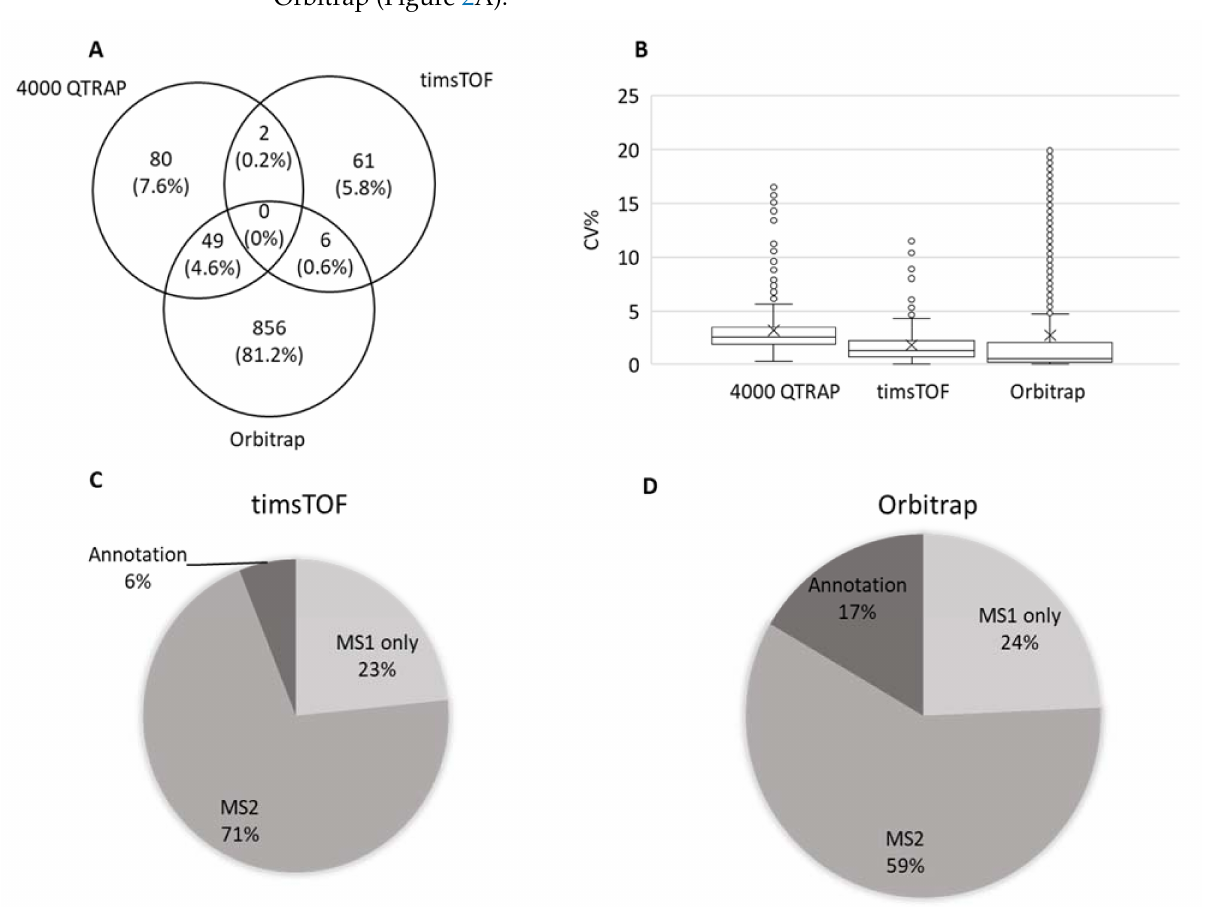
Figure 2. Comparison of metabolomics data from three different mass spectrometry platforms. ( A ) Venn diagram showing overlap of identified metabolites from targeted (4000 QTRAP) and untar- geted metabolomics (timsTOF and Orbitrap). ( B ) coefficient of variance (CV%) of the quantitative data from the three platforms. ( C ) timsTOF data composition. ( D ) Orbitrap data composition. MS1 indicates features only have MS1 spectra and do not have annotation; MS2 indicates features have both MS1 and MS2 spectra but no annotation; annotation indicates those metabolites with both MS1 and MS2 spectra, and annotated with names and chemical